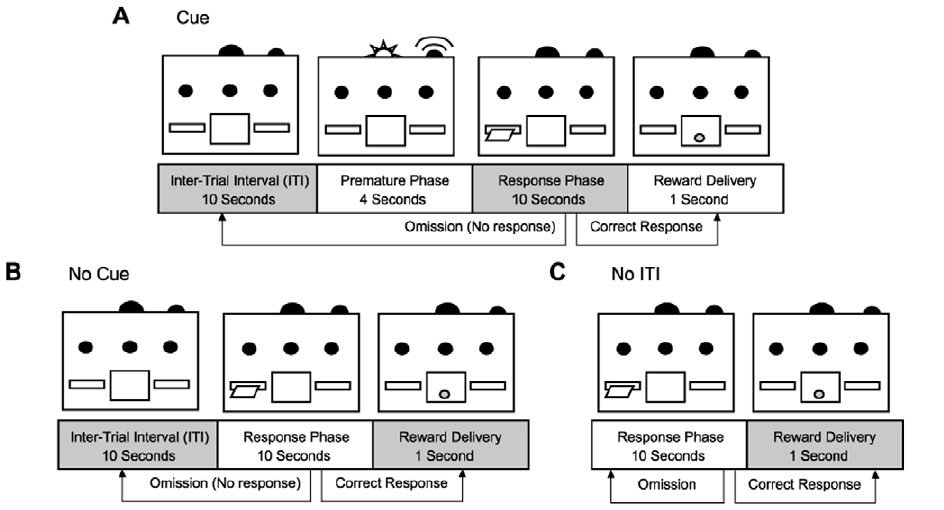
Figure 5. Behavioural training for three control conditions. A. The Cue condition is similar to the Operant Control condition, but the only stimuli are the sound/houselight during the premature phase. B. The ITI only condition had no premature phase, but the ITI was extended to 14 second to match the duration of the cue condition. C. The No ITI condition had no intertrial interval and, therefore, the lever was continuously available, except briefly (1 s) during reward